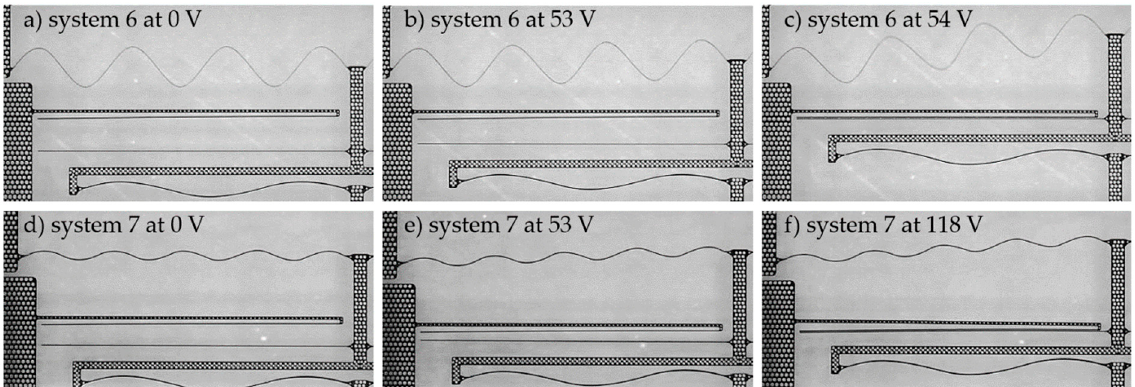
Figure 15. Voltage-dependent total displacement of the 16-step system 6, at ( a ) 0 V, ( b ) 53 V, and ( c ) 54 V and of the 16-step system 7 at ( d ) 0 V, ( e ) 53 V and ( f ) 118 V.